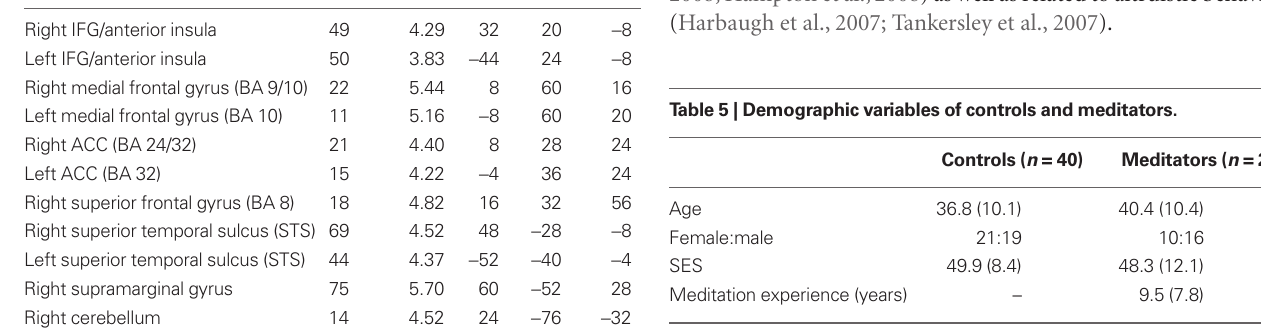
Meditation experience (years) – 9.5 (7.8) Mean demographic variables were compared using two-sample t-tests assuming unequal variance. SD in parentheses. No significant differences (p < 0.05) between controls and meditators were found. SES; social economic